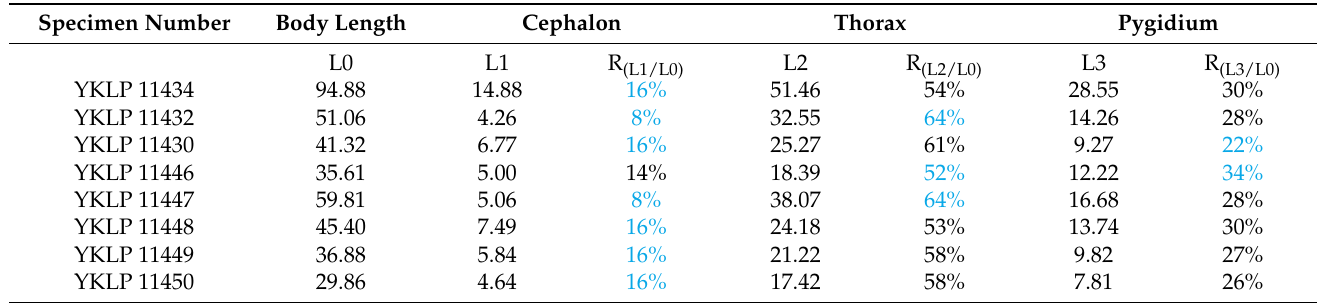
Table A1. Size of eight specimens showing length range of body length, cephalon, thorax, and pygidium (size unit: